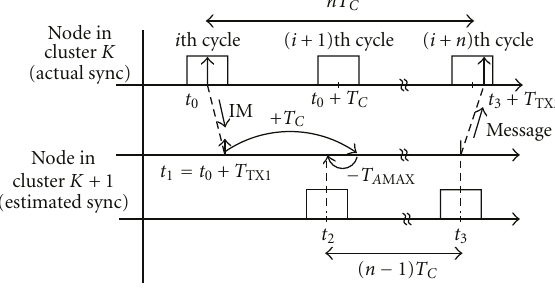
Figure 4: Duty-cycles